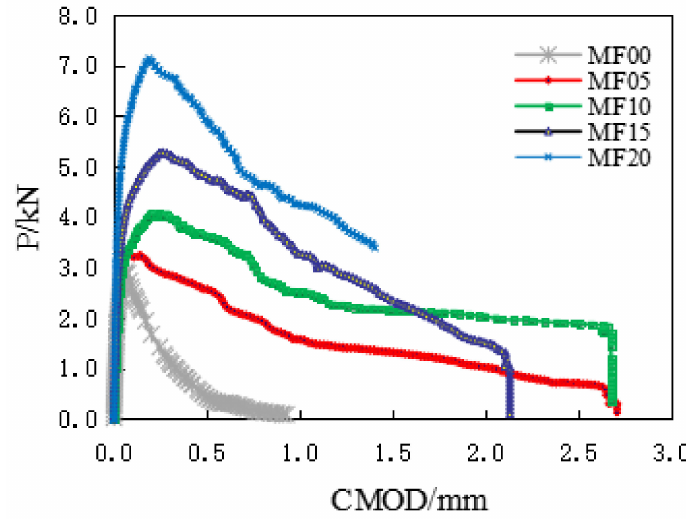
Figure 8. The typical load crack mouth opening displacement (CMOD) curves.